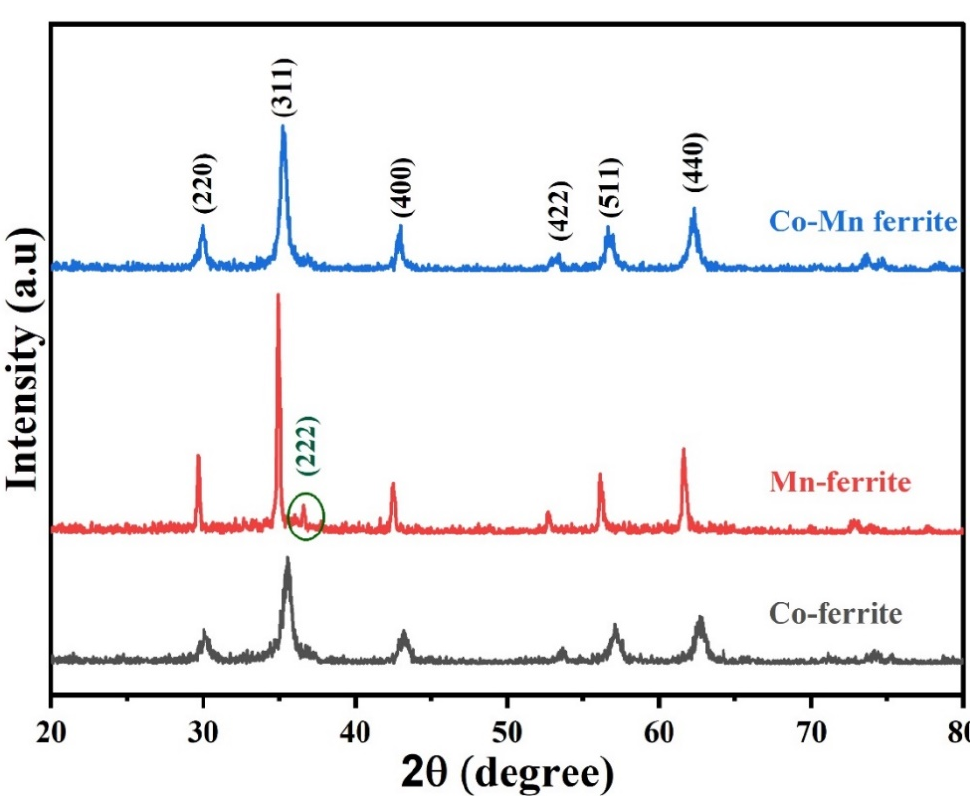
Figure 1. XRD patterns of the prepared ferrite samples.